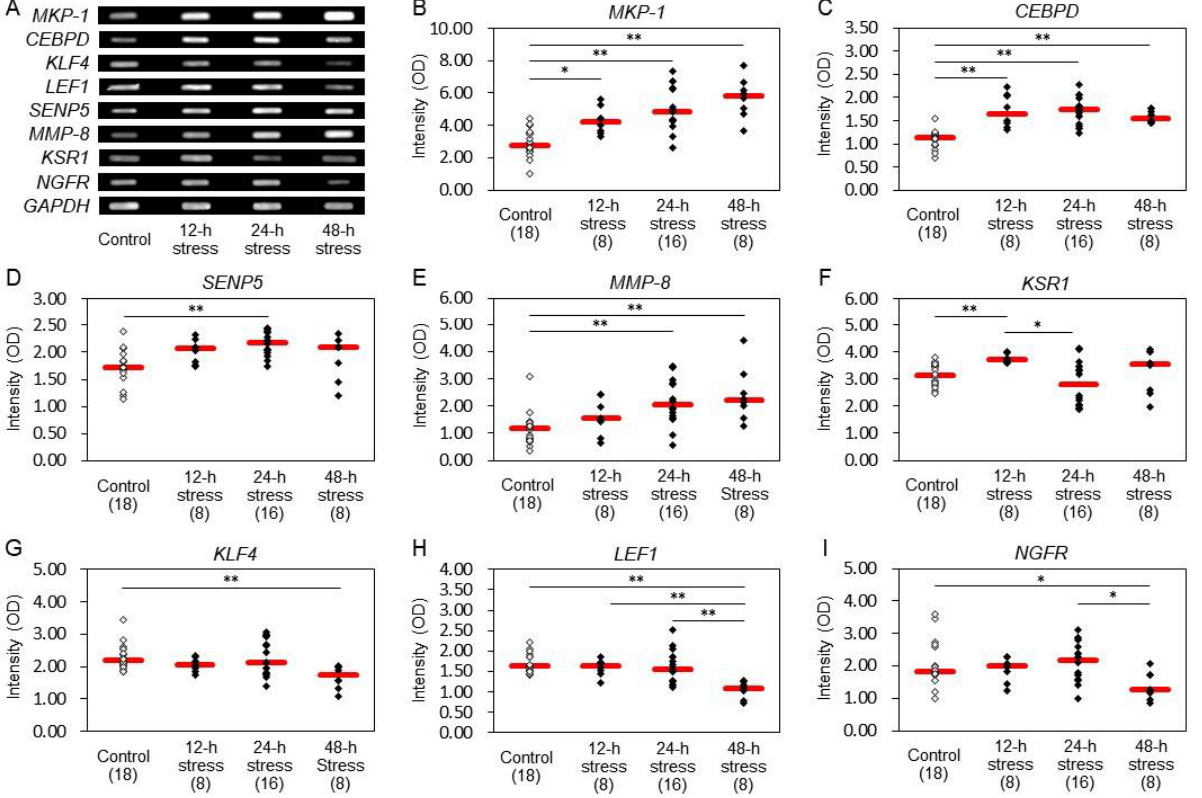
Figure 5. Gene expression profiles in the rat hippocampus. After exposure to stress, the hippocampus was immediately dissected, placed on ice, and mRNA expression was determined by RT-PCR. In preliminary experiments, we clarified the PCR cycle number at which the expression level of each gene saturated, and we adopted the PCR cycle number lower than the gene expression level saturating in the present study. The OD obtained from each sample was verified to be within the range in which the relationship between the amount of DNA and its OD was linear. ( A ) Representative gene expression bands of 8 kinds of genes and glyceraldehyde 3-phosphate dehydrogenase ( GAPDH ) by electrophoresis after RT-PCR. ( B ) MKP-1 ; ( C ) CCAAT/enhancer-binding protein ( C/EBP ) delta ) (CEBPD); ( D ) small ubiquitin-like modifier proteins ( SUMO ) 1 / sentrin-specific peptidase 5 ( SENP5 ); ( E ) MMP-8 ; ( F ) kinase suppressor of Ras 1 ( KSR1 ); ( G ) Krüpppel-like factor 4 ( KLF4 ); ( H ) lymphoid enhancer-binding factor 1 ( LEF1 ); ( I ) NGFR . The intensities of optical densities are expressed relative to GAPDH expression in each sample. Red bars represent the median. Parenthesis: the number of animals. * p < 0.05, ** p < 0.01 by Steel − Dwass test. Stress for 12 h and/or 24 h stress caused a significant increase in the expression of MKP-1 , CEBPD , SENP5 , MMP-8 , and KSR1 . Stress for 48 h induced a significant increase in MKP-1 , CEBPD , and MMP-8 , with a decrease in KLF4 , LEF1 , and NGFR